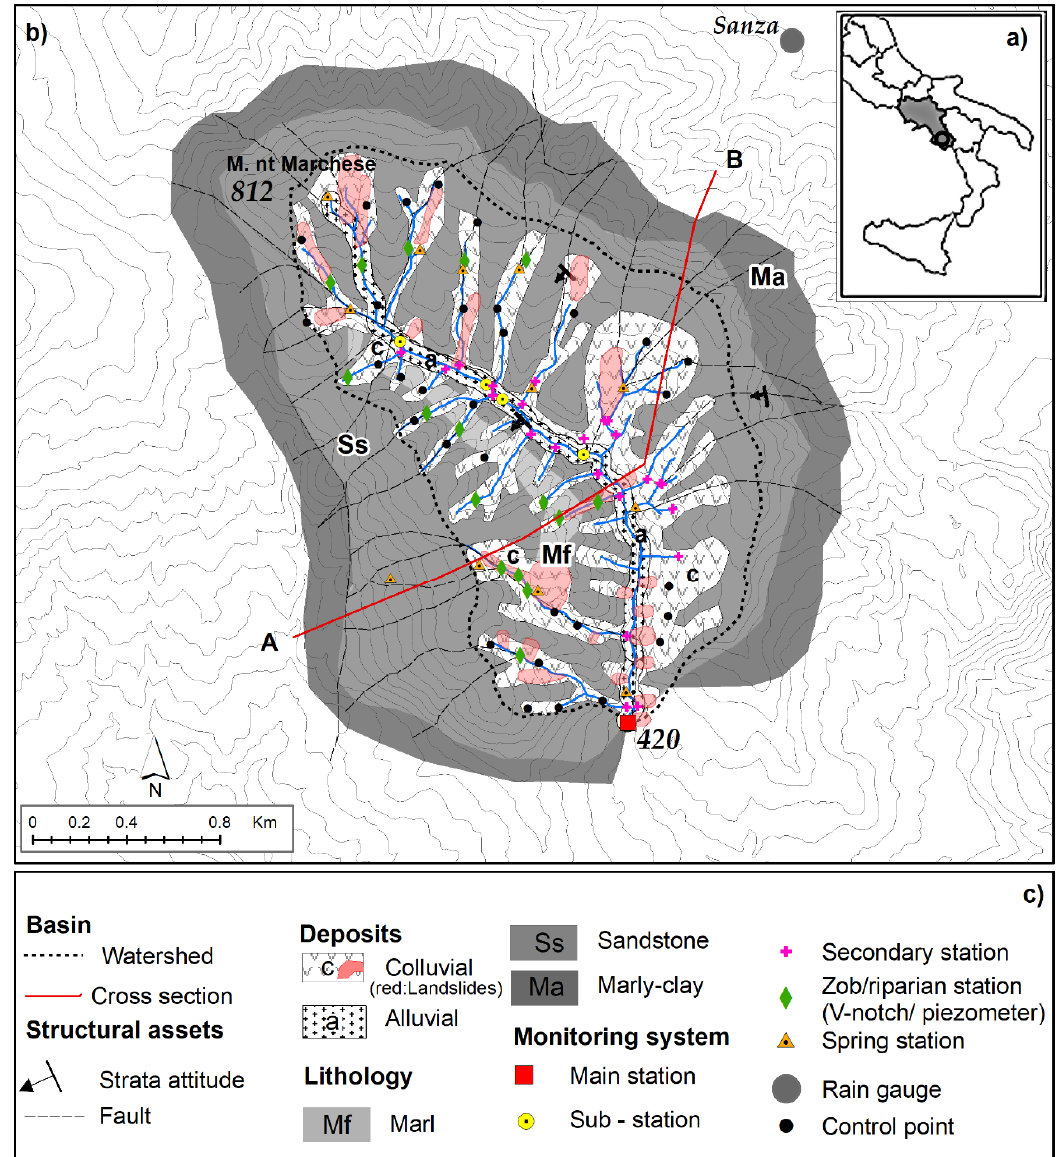
Figure 1. Ciciriello experimental catchment located in the southeast of Campania (Southern Italy) (modified from [35] ). ( a ) Upper right inset: geographical location of the Bussento river basin; ( b ) left inset: schematic geological map, hydro- structural features, and location of the monitoring stations; ( c ) legend.